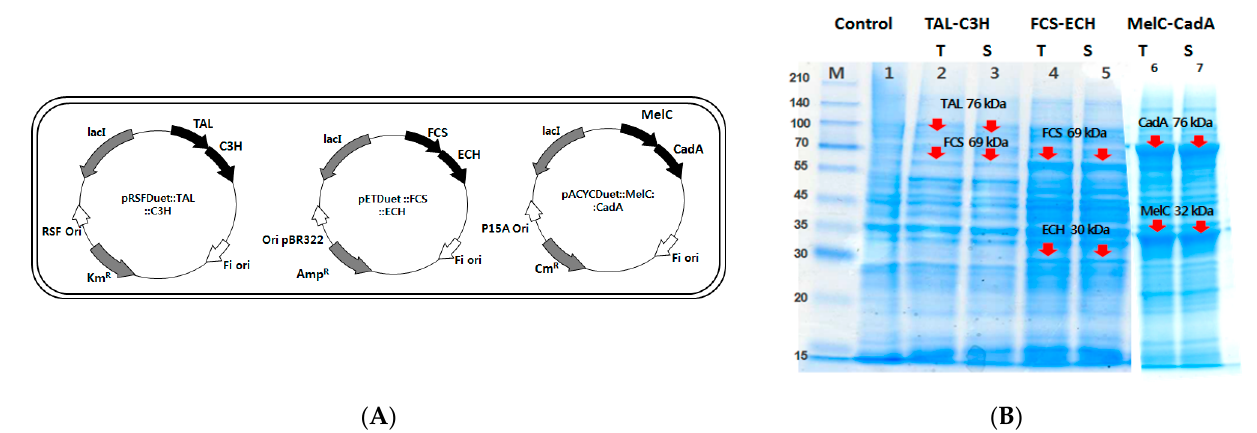
Figure 4. ( A ) Construction of TAL-C3H, FCS-ECH, and MelC-CadA co-expression plasmids. ( B ) SDS-PAGE analysis of TAL, C3H, FCS, ECH, MelC, and CadA enzyme co-expression in E. coli BL21(DE3). Control indicates E. coli BL21(DE3) cells without protein overexpression. Each T and S indicates the total and soluble fraction in each protein, respectively.